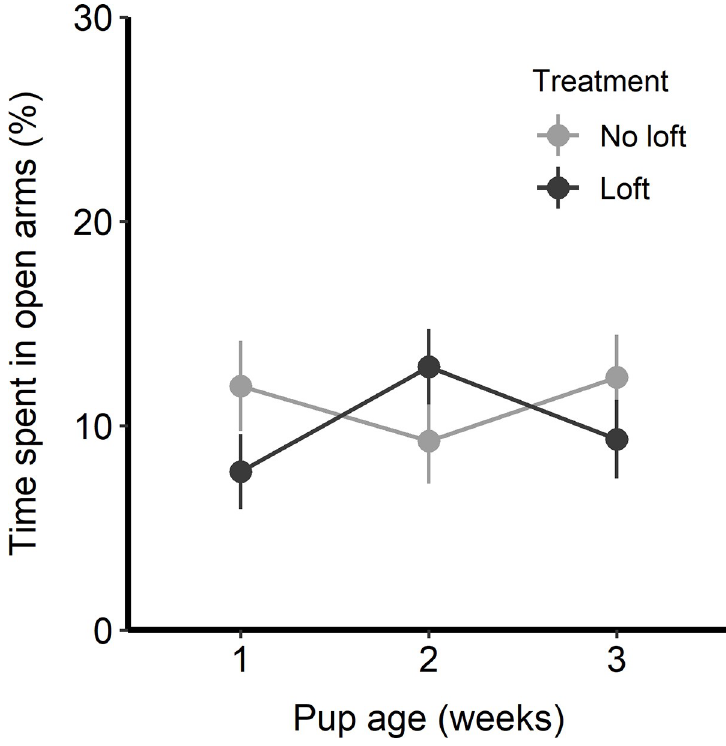
Fig 6. Mean time spent in the open arms during the elevated plus maze test. Rats were tested once per week over the pup rearing period. Results are shown separately by treatment with 9 rats in the loft treatment and 7 in the no loft treatment. Plot depicts the LS means and standard errors from the model